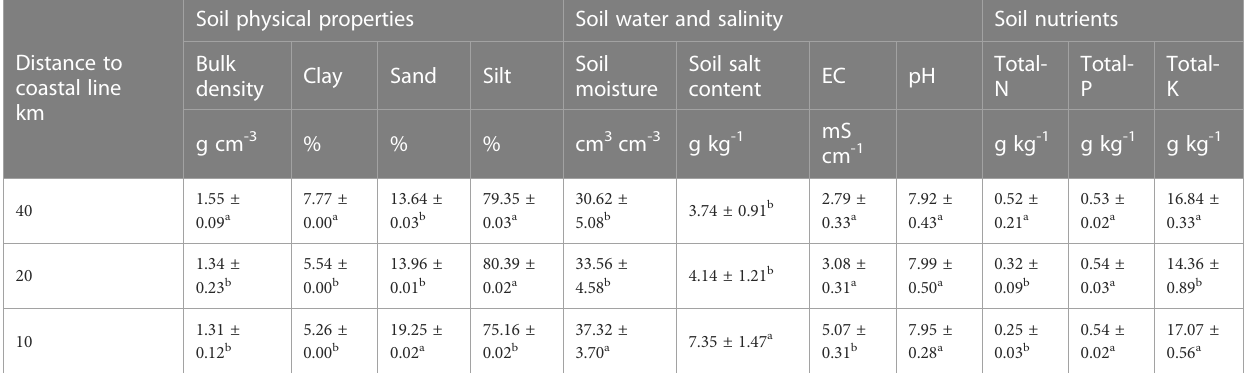
TABLE 1 Selected soil basic physicochemical properties in the investigated Tamarix chinensis shrub plots at the three different distances to coastal line.